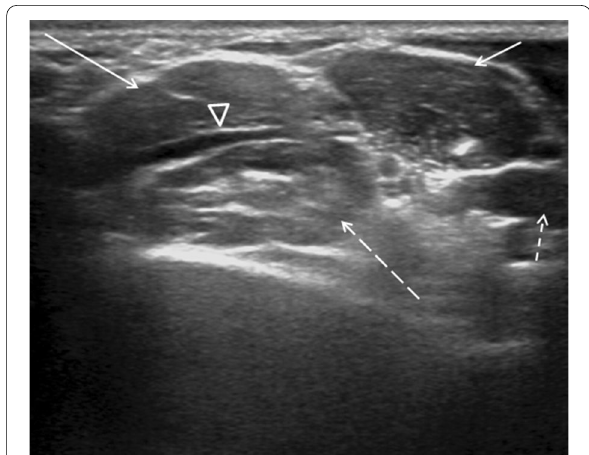
Fig. 3 B-Mode US: transverse scan of the cost-clavicular space which highlights the anterior scalene muscle (short arrow), the middle scalene muscle (long arrow), and the posterior scalene muscle (long-dashed arrow). Subclavian artery (head of arrow). Subclavian vein (dashed short arrow)